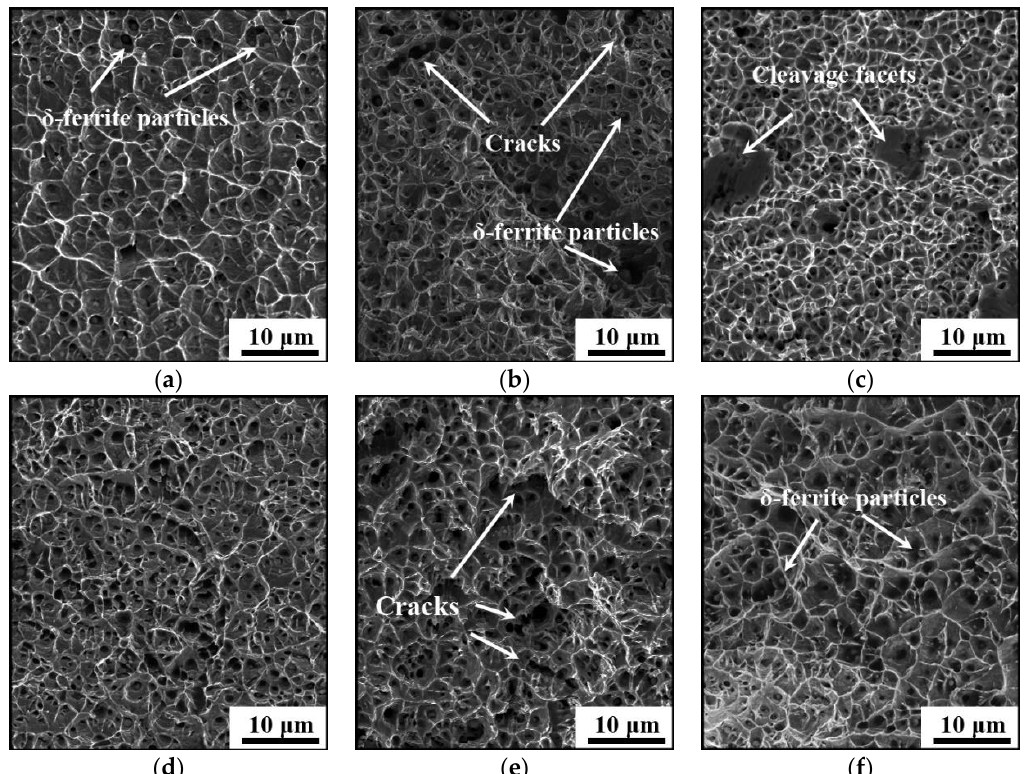
Figure 11. Fracture surfaces of the longitudinal tensile samples under ( a ) low LEI and low CR; ( b ) low LEI and medium CR; ( c ) low LEI and high CR; ( d ) high LEI and low CR; ( e ) high LEI and medium CR; ( f ) high LEI and high CR.